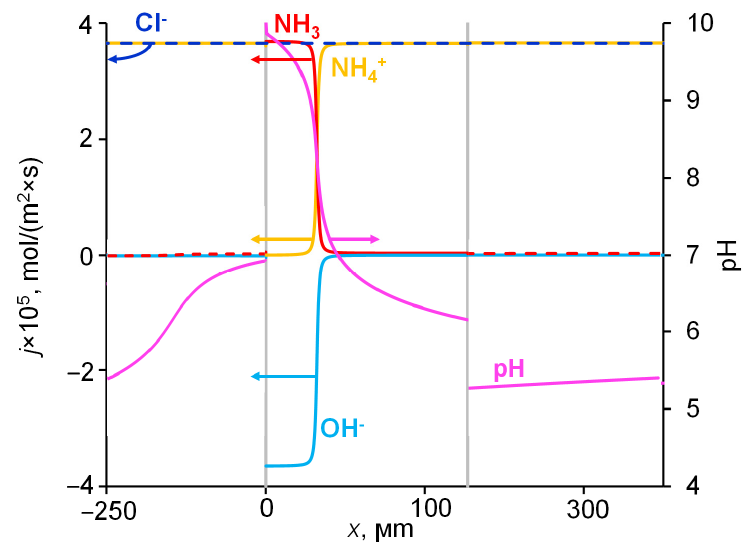
Figure 8. Dependence of the fluxes of all species present in the membrane system and pH dependence on the coordinate. The flux of H + ions is negligibly small in all parts of the system and not shown. The secondary y axis refers to pH. Simulation for an AMX membrane and 1 M NH 4 Cl feed solution with the input parameters shown in Table 1.